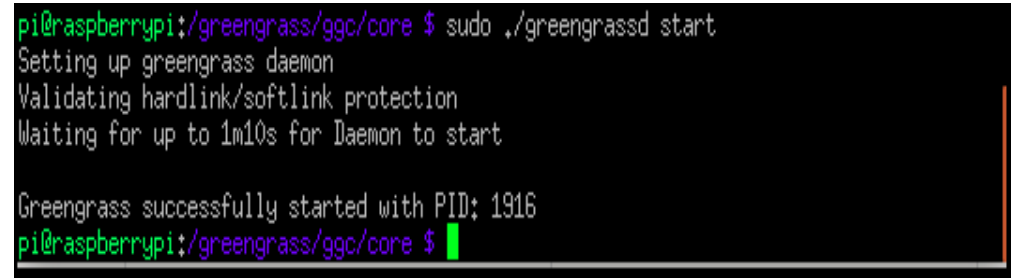
Figure 11. Successfully exchanged messages of different types: PublishOut.Success, PublishIn.Success, Connect.Success, Ping.Success, Subscribe.Success. The x-axis represents hours of the day, and the y- axis one day. The proposed IoT model showed that we could ensure privacy and security measures set before we allowed the IoT enabled device or node to communicate or share its data. Upon successful implementation and configuration, we are sure that our assets are protected. The described model in this paper can be used to provide secure IoT environments and systems with fog/edge computing layers and sensors fusion. Many real-life applications can utilize this model, such as healthcare, military, disaster recovery, and many others [35]. Let us consider the healthcare case; for example, by using the proposed policy-based model, the users will have the ability to trust their healthcare